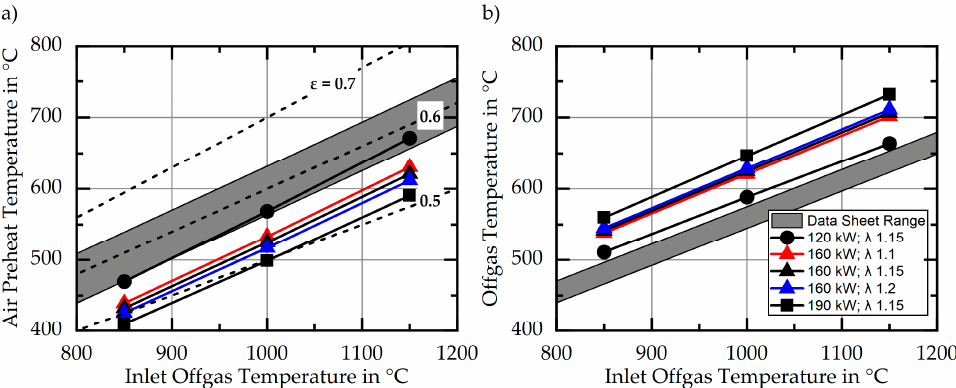
Figure 11. Air preheat ( a ) and off-gas temperature ( b ) in comparison with datasheet values [11].